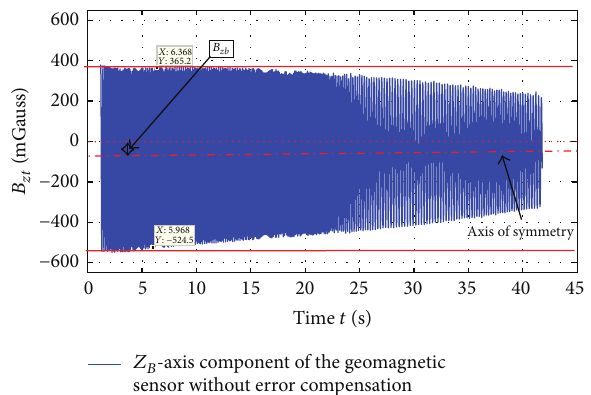
Figure 19: 𝑍 𝐵 -axis component of geomagnetic sensor without compensation.